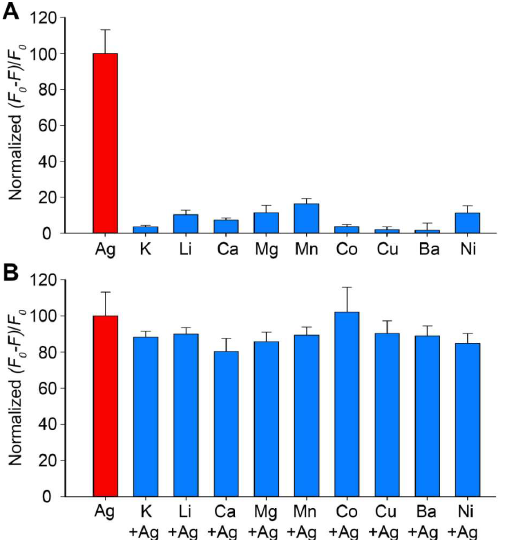
Figure 5. Fluorescence changes at 520 nm of the M-DNA in the presence of ( A ) 50 nM non-Ag + metal ions (blue) and ( B ) 50 nM non-Ag + metal ions plus adding 50 nM Ag + (blue). The fluorescence change in the presence of only 50 nM Ag + was shown as a reference (red). Error bars were standard devia- tions obtained from three replicative experiments. F 0 : initial fluorescence intensity in the absence of Ag + ; F : fluorescence intensity after adding 50 nM AgNO 3 or other metal ions.